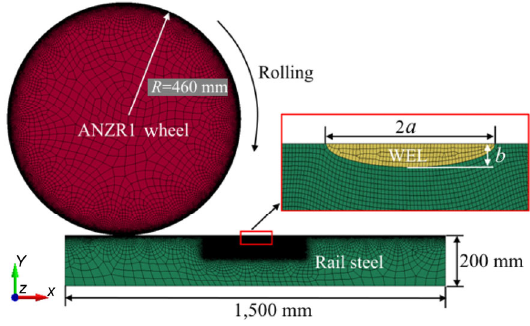
Fig. 2 Illustration of the finite element simulations.